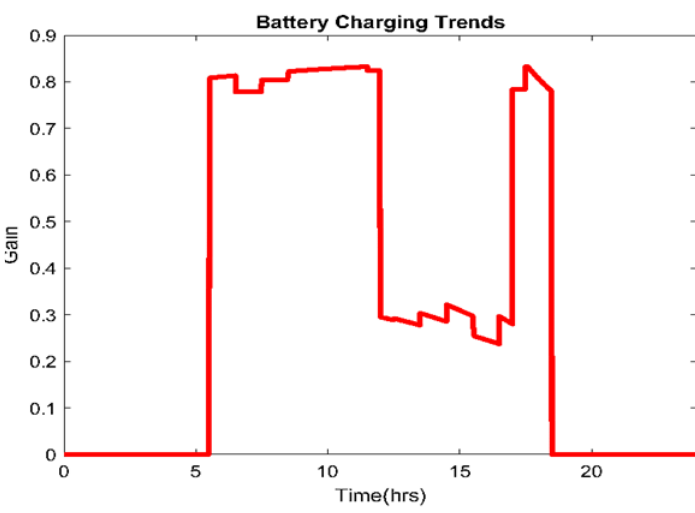
Figure 11. SoC of the battery.